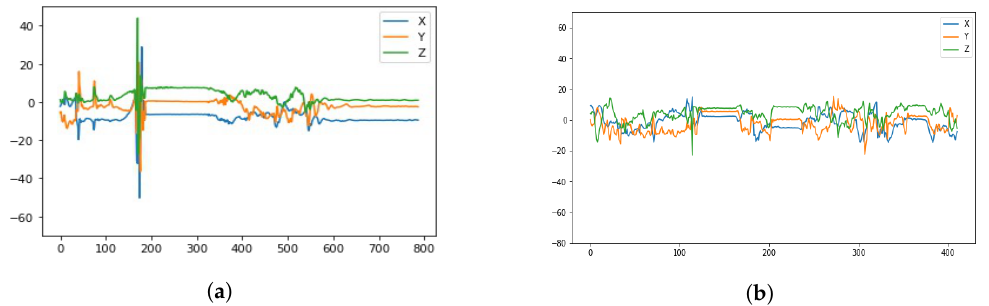
Figure 1. Two different smartwatch accelerometer data. ( a ) Acceleration from a fall. ( b ) Acceleration from putting on a